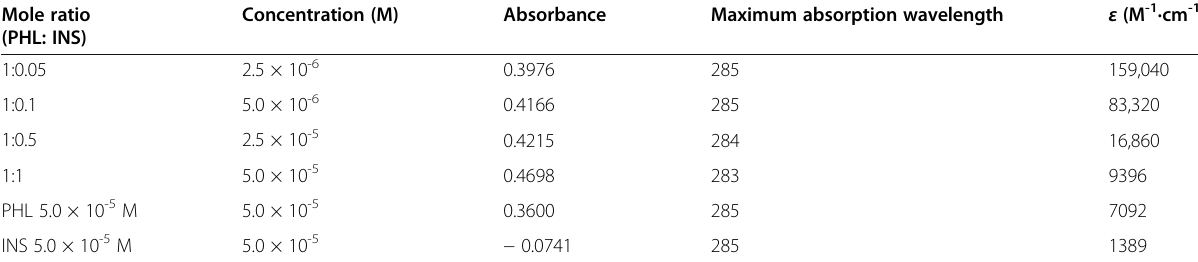
(Fig. 2) similar to Kierdaszuk ’ s results (Kierdaszuk et al.